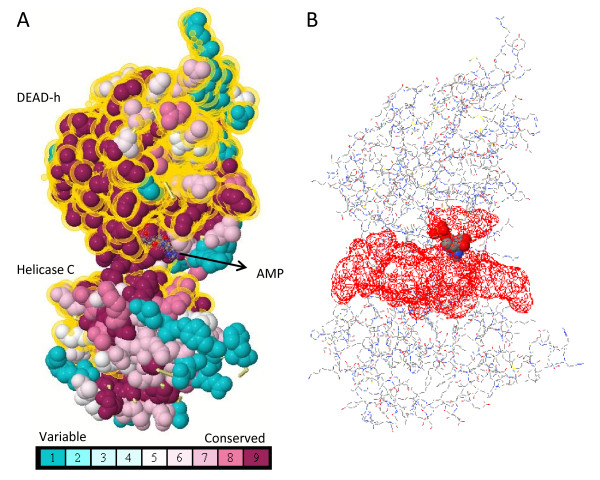
The conserved domain and ATP binding site of the human DDX3X. A. The conservation score distribution on the human DDX3X (PDB: 2I4I) was assigned based on the empirical Bayesian method by ConSurf [21]. The domain regions are highlighted in dot-yellow halos. B. The ATP binding cleft depicted in PDBsum [64] corresponds to the conserved region in A.